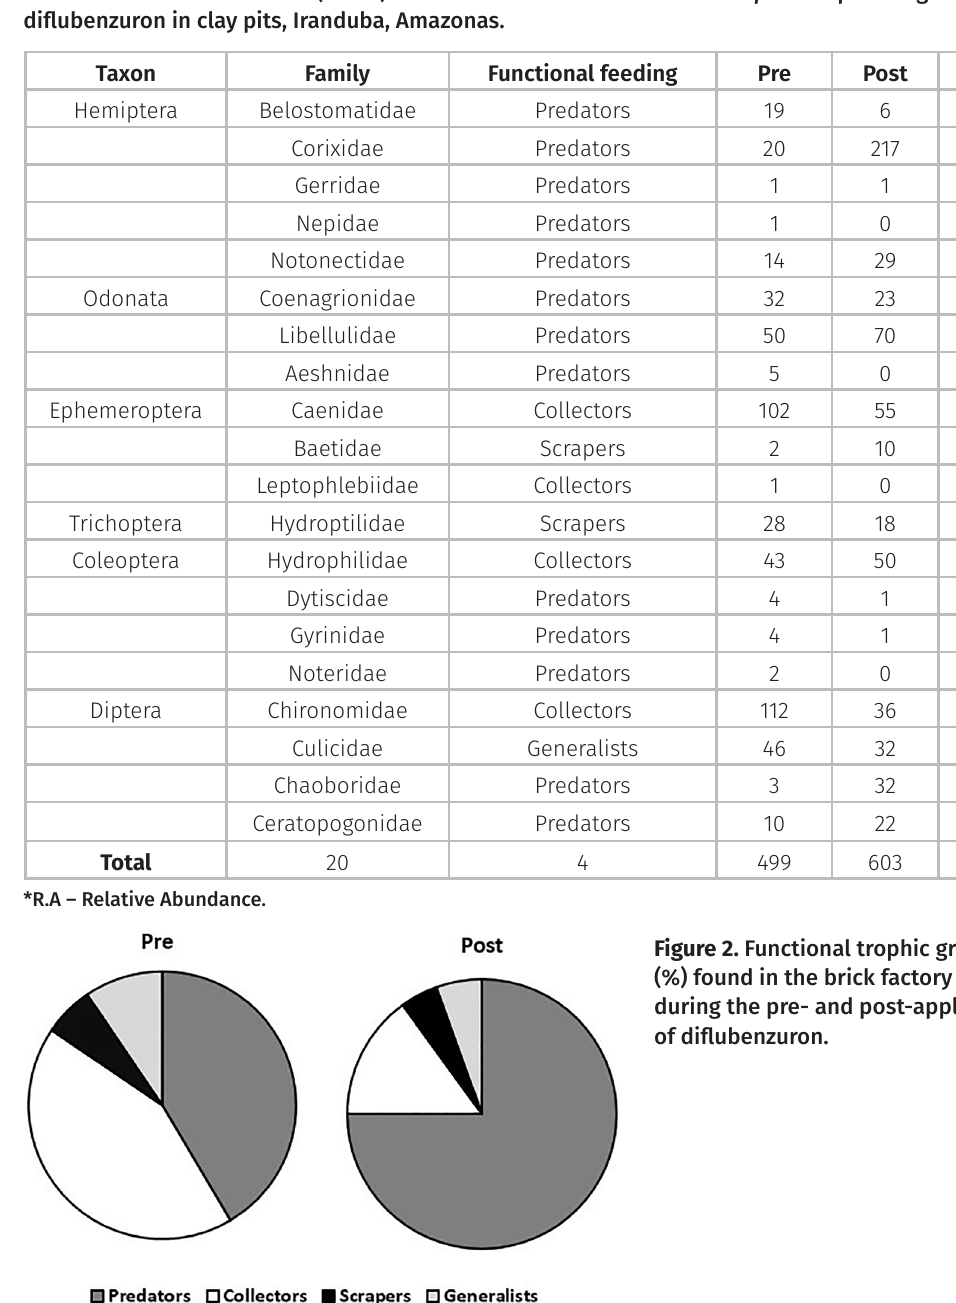
Table II. Relative abundance (R.A %) of associated insect fauna with Anopheles sp. during the field experiment with diflubenzuron in clay pits, Iranduba, Amazonas.